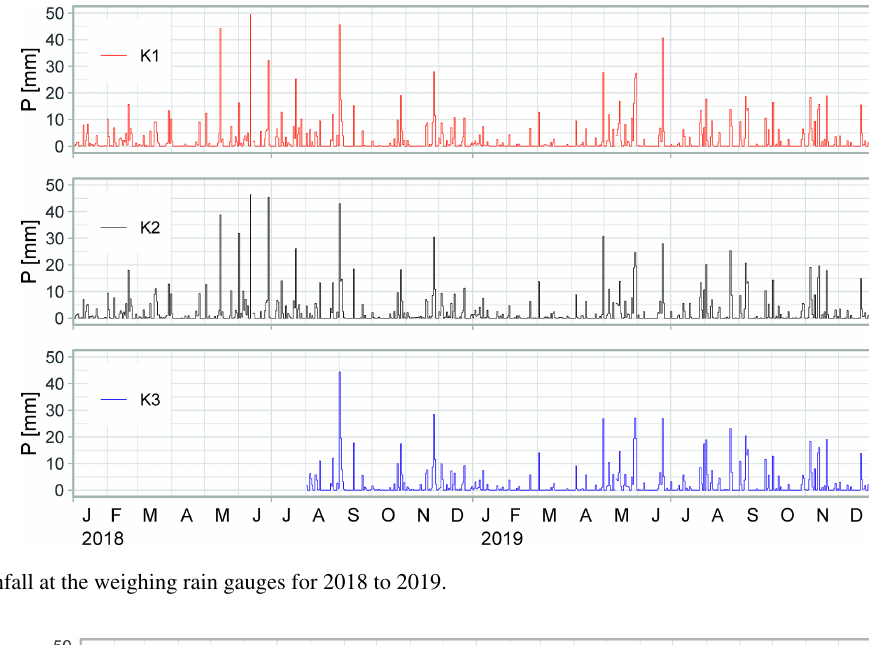
Figure 8. Daily rainfall at the weighing rain gauges for 2018 to 2019.